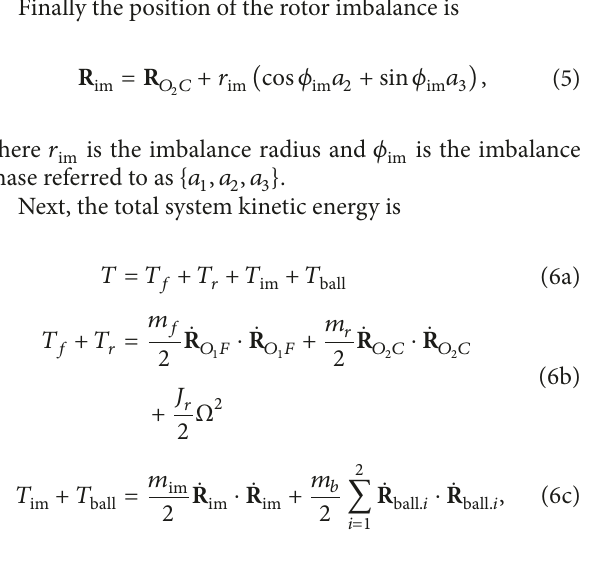
Furthermore, the position vectors of the AB masses are described by (𝑡) 𝑎 (𝑡) 𝑎 + 𝑟 ( cos 𝜙 + sin 𝜙 ) R ball .𝑖 = R 𝑂 𝑏 𝑖 2 𝑖 3 2 𝐶 for 𝑖 = 1, 2, where 𝜙 1 (𝑡) and 𝜙 2 (𝑡) are balancer mass angular positions measured relative to {𝑎 1 , 𝑎 2 , 𝑎 3 } and 𝑟 𝑏 is the AB ball track